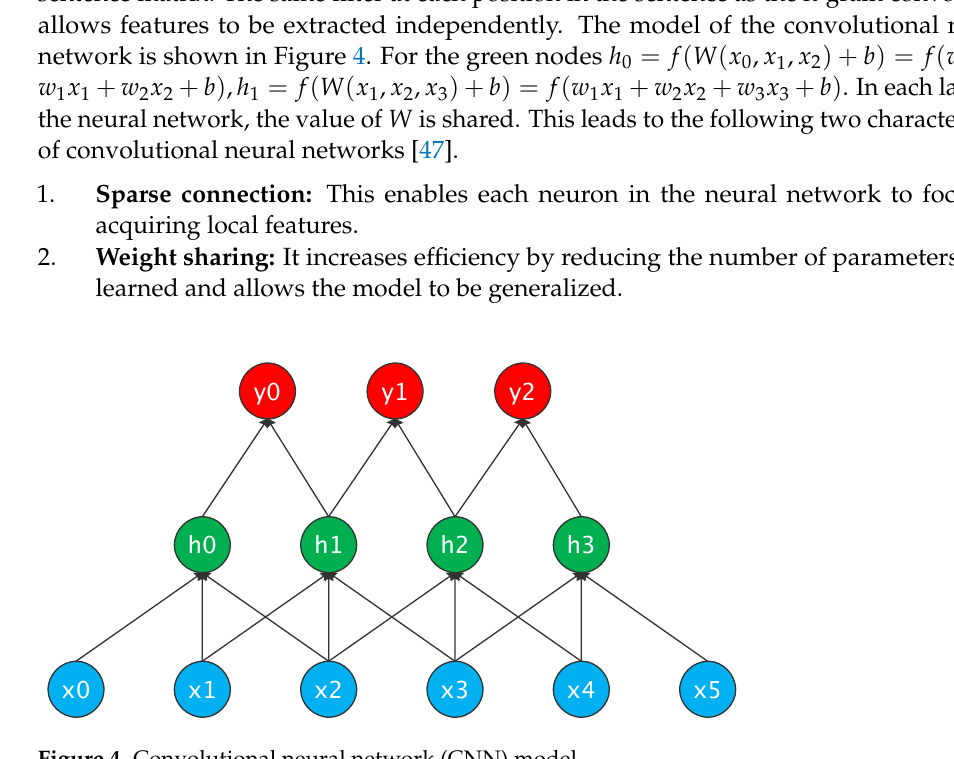
Figure 4. Convolutional neural network (CNN)